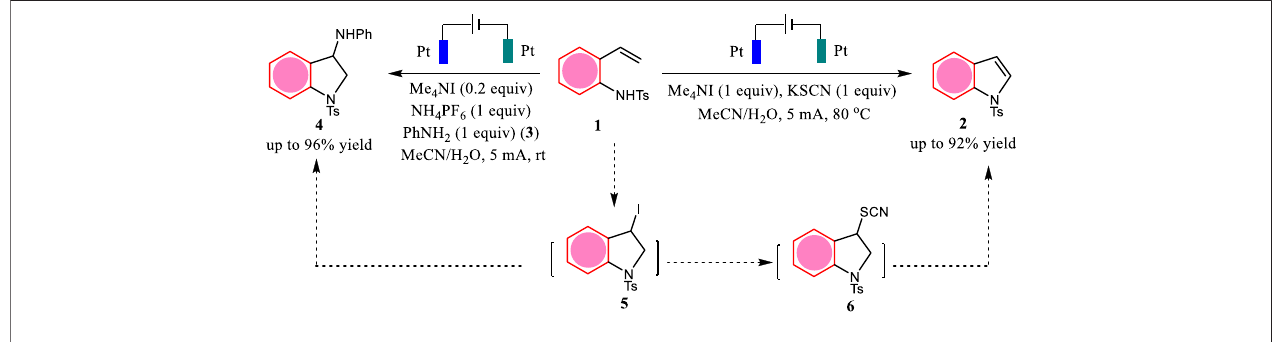
SCHEME 1 | The electrochemical synthesis of indoles and